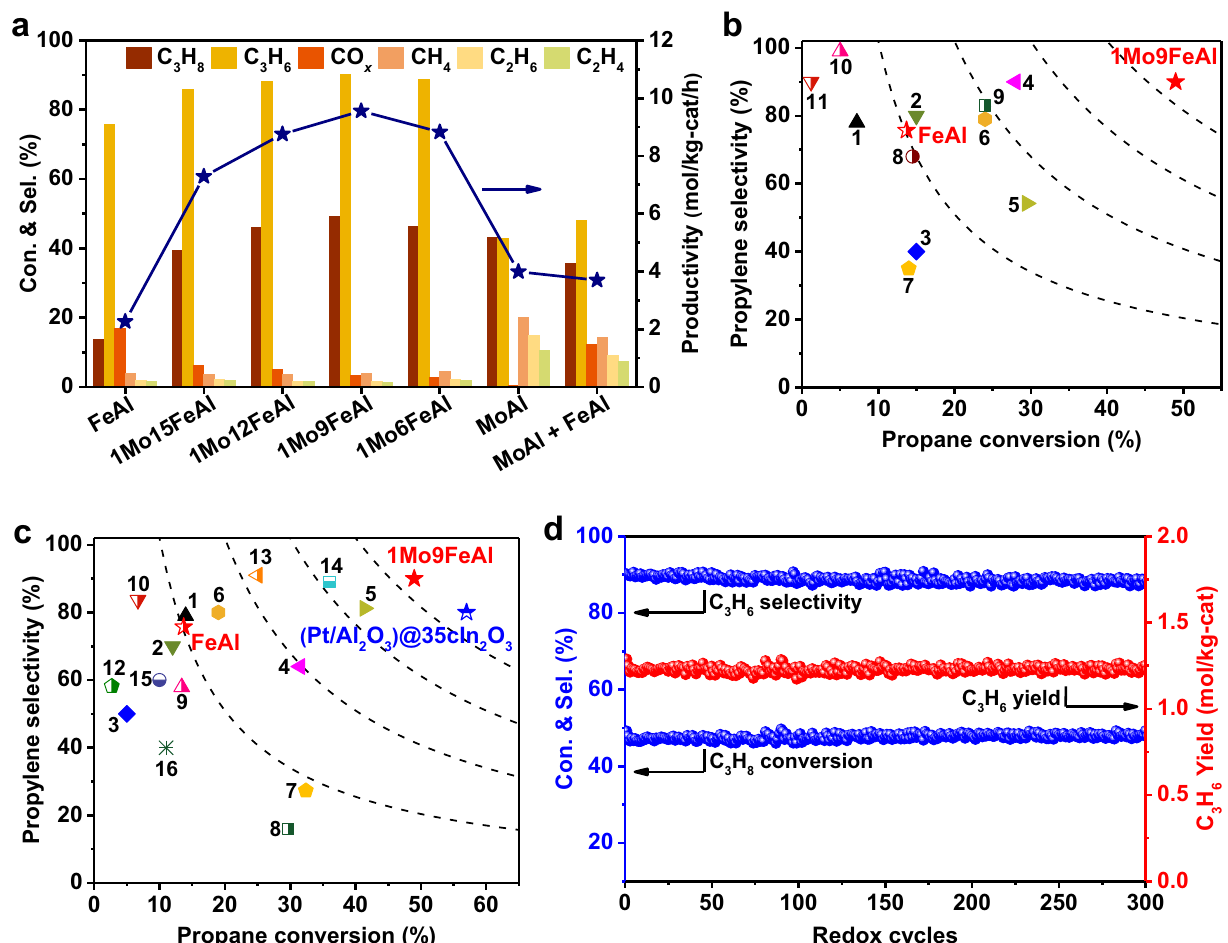
Fig. 1 | Catalytic performance and stability test. ( a ) Products distribution over different redoxcatalysts atthe fourth minute, FeAl+MoAlrepresentsthe physical mixtureofMoAlandFeAl.Comparisonof1Mo9FeAlwiththecatalyticperformance of reported ( b ) Fe-based catalysts and ( c ) ODH catalysts. All referenced catalysts and citations are listed in Supplementary Tables 1 and 2. ( d ) Redox stability of